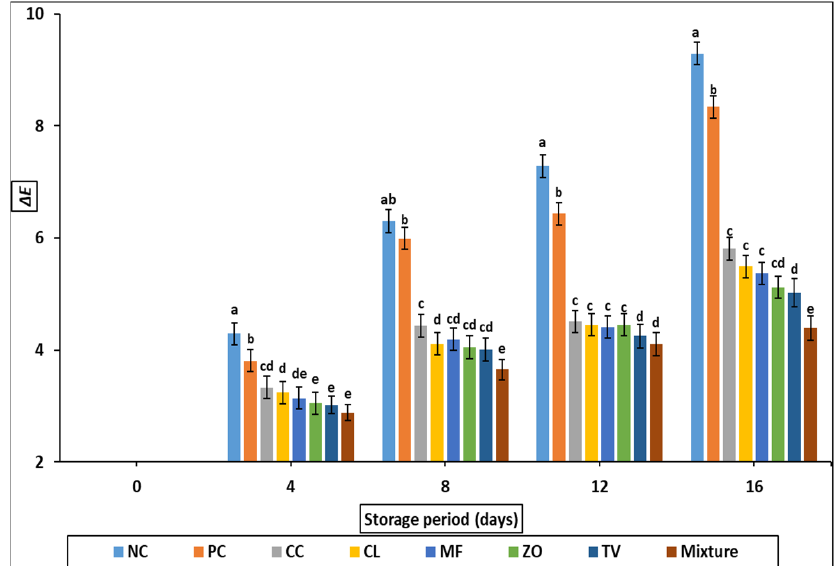
Figure 4. Color difference changes ( ∆ E*) of cold stored rabbit meat formulated with different aqueous plant extracts. Columns with different letters are significantly different ( p < 0.05).